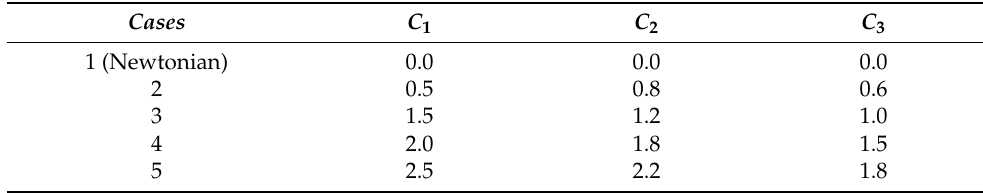
Table 2. Non-dimensional parameters C 1 , C 2 , and C 3 for different cases.